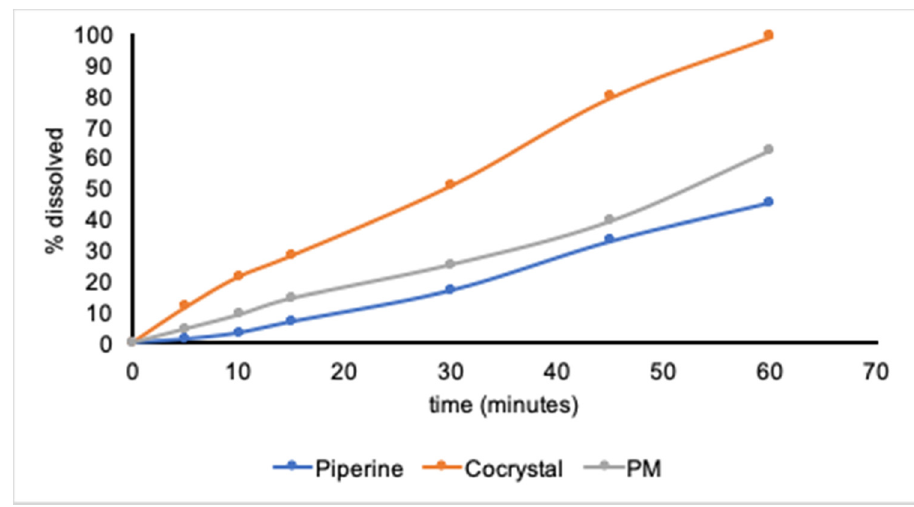
Figure 5. Dissolution rate profile of piperine (blue), physical mixture (grey), and the cocrystal (orange).